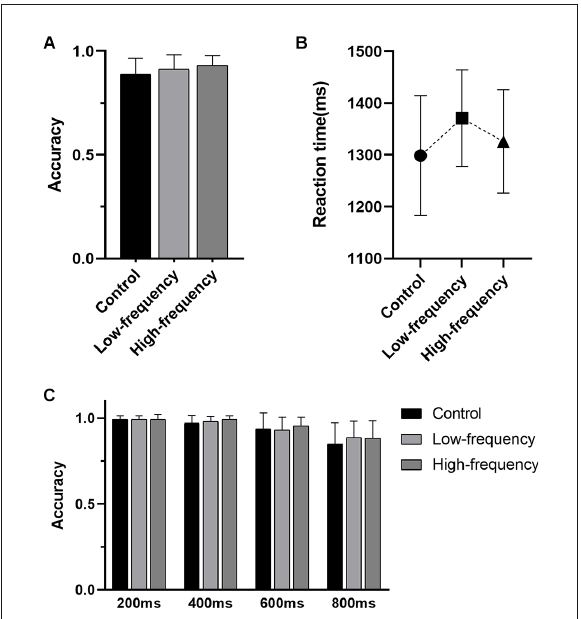
FIGURE1 Results of the Stop-signal task. (A) The accuracy of the GO trials, (B) thereactiontimeoftheGotrials, (C) theaccuracyoftheSTOP trials with different stimulus onset